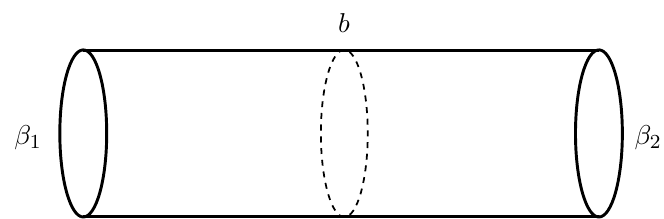
Figure 1 . The cylinder geometry. We specify two boundary conditions β 1 and β 2 at each end. The only modulus is the circumference b